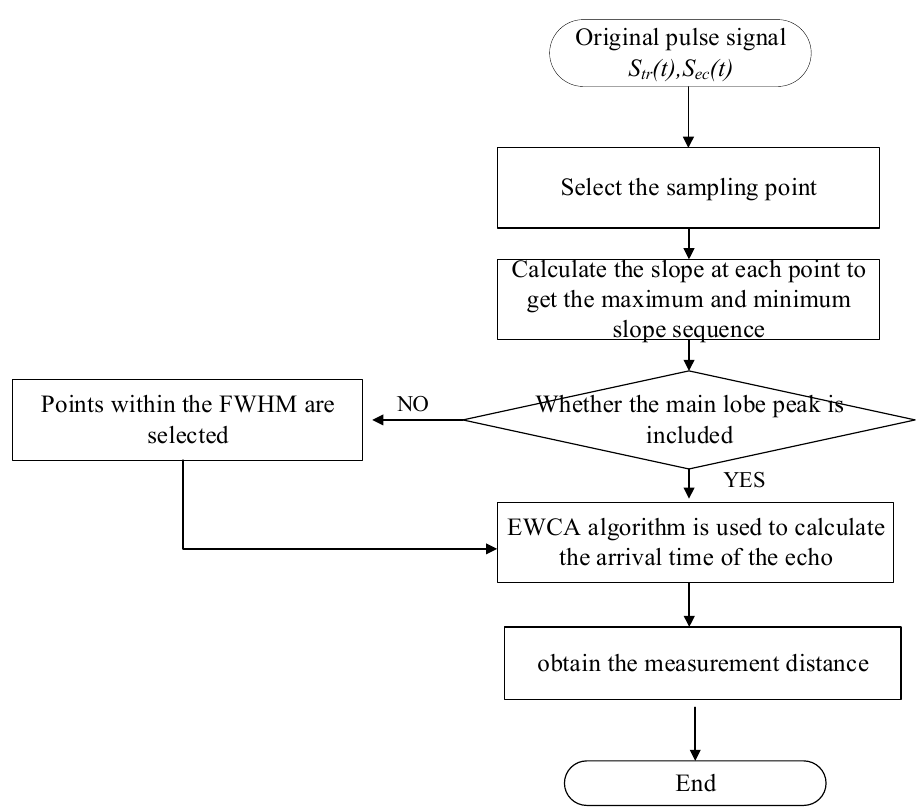
Figure 1. The flow chart of the proposed EWCA method. The points between the maximum and minimum slopes are selected as the main lobe sequence sampling points, which have the largest part of the effective signal energy of the laser pulse and can well represent the pulse signal. Our algorithm does not depend on the overall smooth waveform and increases the proportion of valid signals to suppress inter ‐ ference clutter noise. The moment is calculated when the signal moment of energy reaches equilibrium in the waveform centroid, and the selection of points does not depend on the fixed window function. It has a certain degree of self ‐ adaptation, which can meet the ap ‐ plication of engineering. 4. Simulation Analysis The parameters of the Lidar system in the simulation are set as follows: the sampling frequency is 5 Gsa/s, the transmitted pulse width with 3 dB is 4 ns, the pulse repetition frequency is 200 kHz, and the distance to the target is 50 m. In Figure 2a, the transmitted and the echo pulse signals are shown. The pulse signal after the finite impulse response (FIR) digital filter is shown in Figure 2b. Adding the FIR can eliminate the high ‐ order frequency and the direct current component. It is more help ‐ ful for further research and analysis.